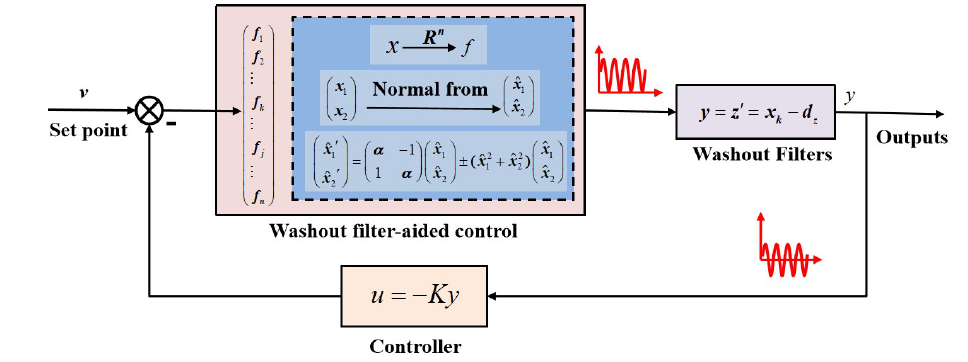
Figure 2. Block diagram for bifurcation control with washout-filter-aided